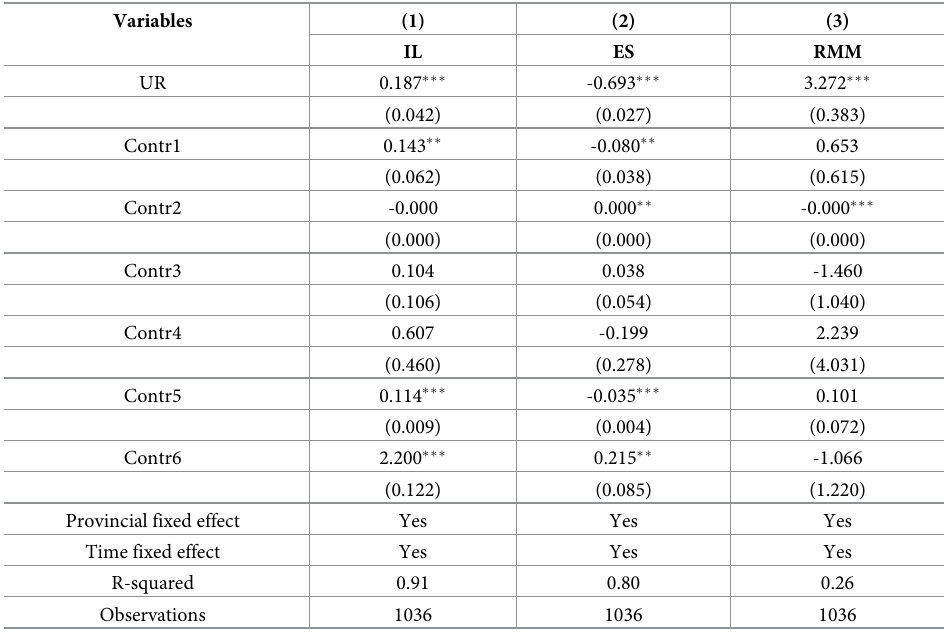
Table 4. Regression results of Model 2 a